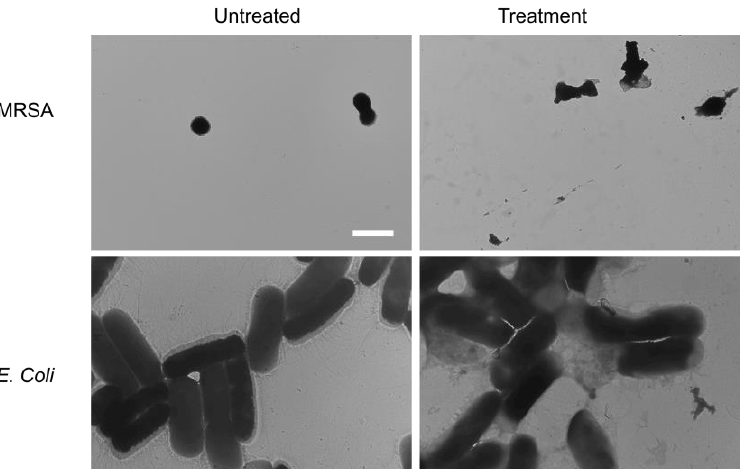
Figure 5. TEM graphs of MRSA and E. coli in the presence and absence of YW-1 at 2 × MIC, scale bar 2µm.